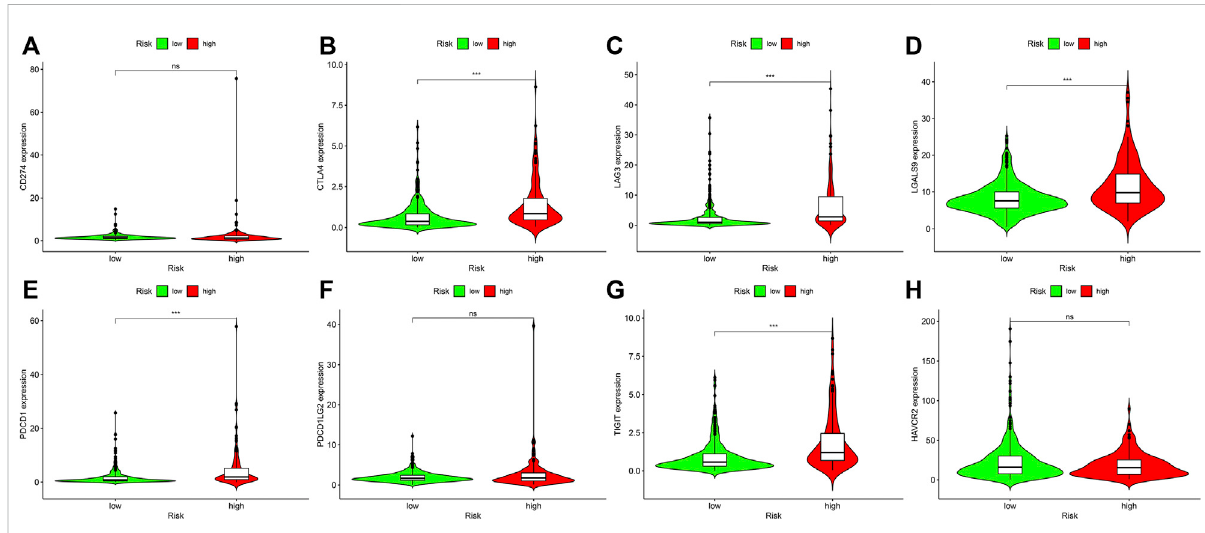
FIGURE 7 Associations between risk model and genes in ccRCC. Comparison of the expressing levels of (A) CD274. (B) CTLA4. (C) LAG3. (D) LGALS9. (E) PDCD1. (F) PDCD1LG2. (G) TIGIT. (H) HAVCR2. Ns: not signifcant; * p < 0.05; ** p < 0.01; *** p < 0.001.